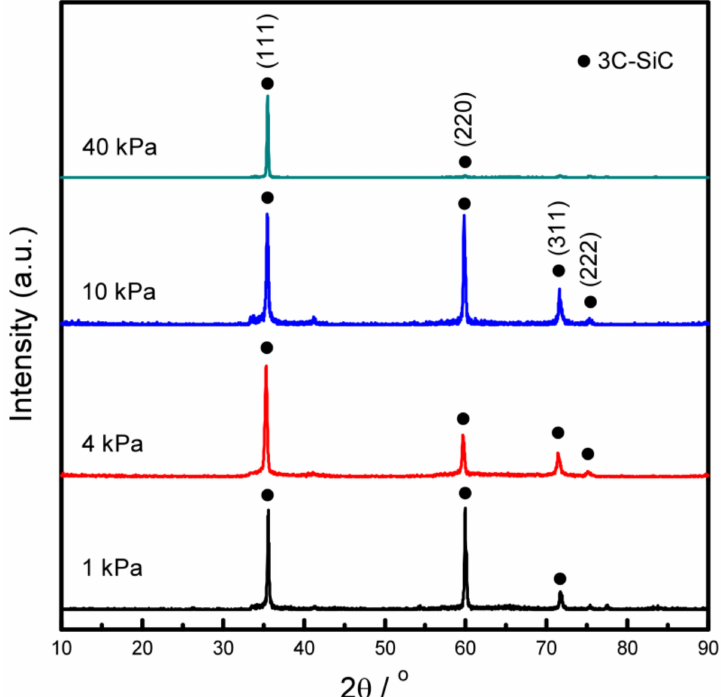
Figure 3. XRD patterns of the 3C-SiC deposits prepared at T dep = 1673 K at various P tot